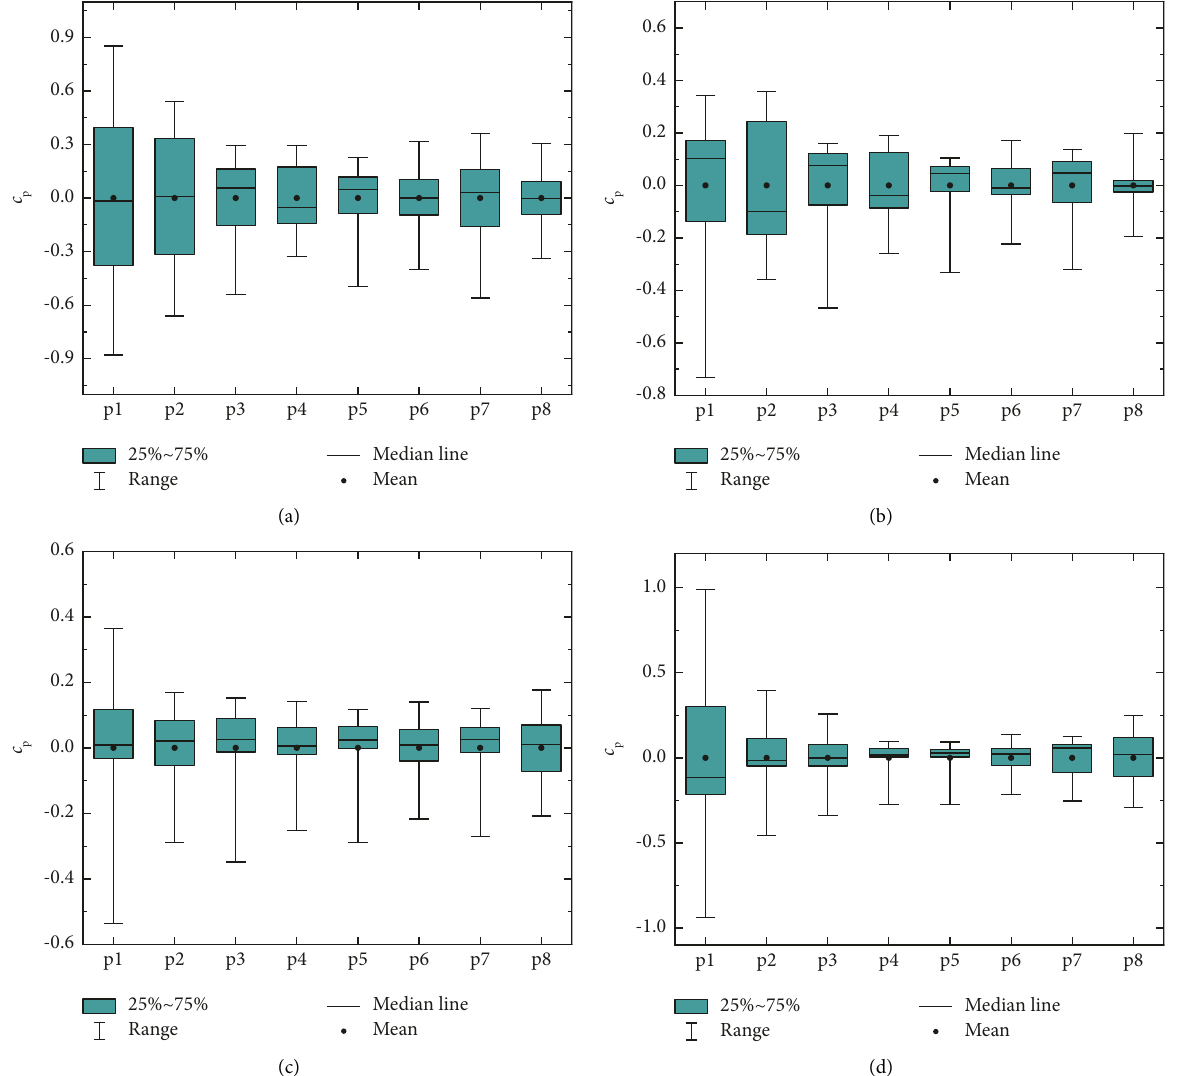
Figure 9: Amplitude and the average value of monitoring points under different flow rates. (a) 0.4 Q